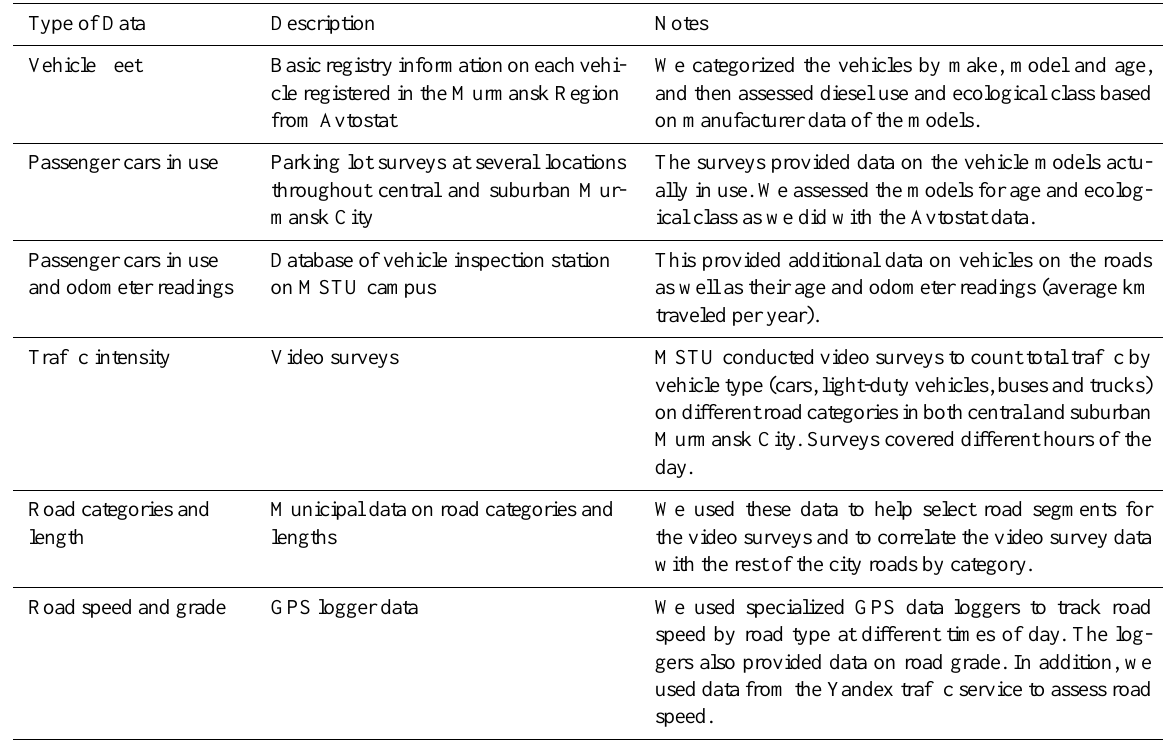
Table 2. Main data sources on vehicle fleet and activity. Type of Data